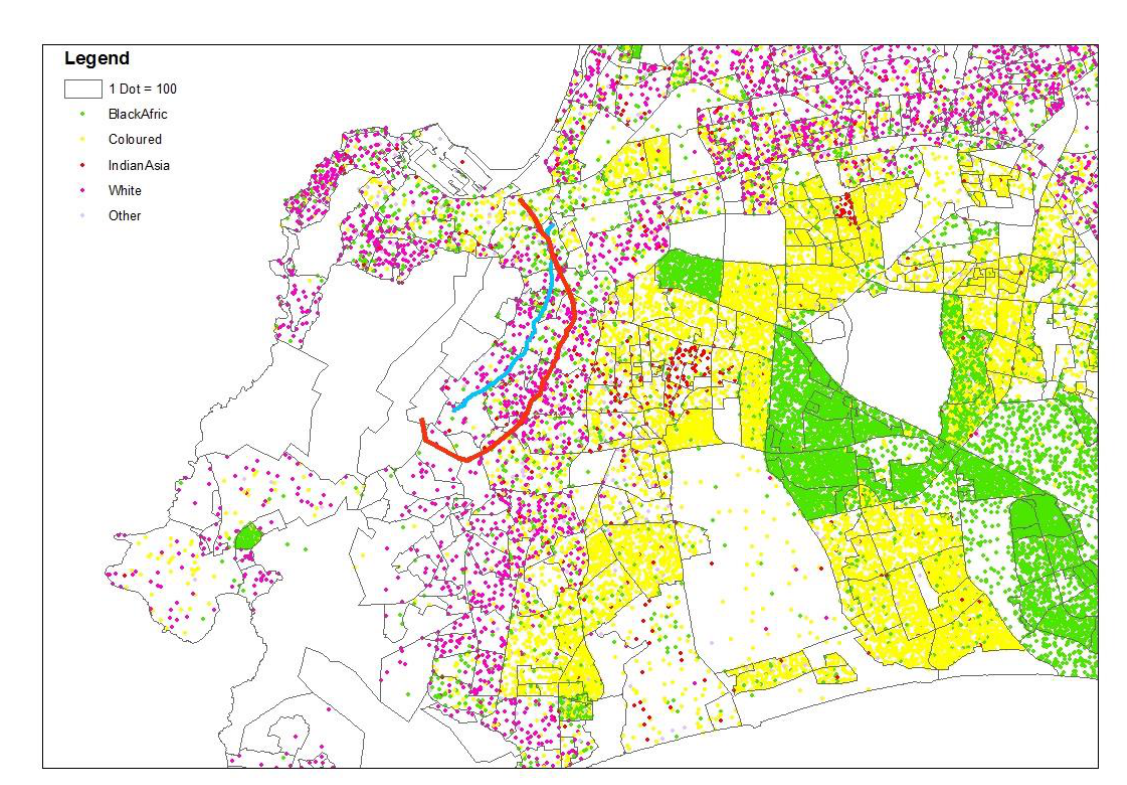
Figure 2 Location of Van Riebeeck’s hedge overlaid on a dot density map Figure 2 is an example of the resulting map. It is a dot density map, showing the populations by race group (these are the race groups that were officially recognised in the apartheid era, and continue to live on in the ‘new’ South Africa ). One green dot = 100 black people, one purple dot = 100 white people, one yellow dot = 100 coloured people and one red dot = 100 Indian people. The boundary hedge is shown as a red line, and students observe that the location of the original hedge is close to the apartheid boundary between white and coloured areas. They can see that race and place are correlated, and the invisible hedge still largely keeps out black people from the valuable land close to Table